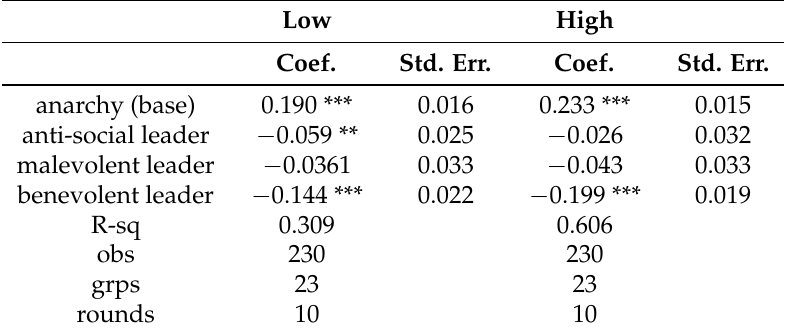
Table 7. Impact of leader behavior on income inefficiency. Random error-Generalized least squares regression with robust standard errors clustered across groups; Dependent variable : relative deviation from the efficient group